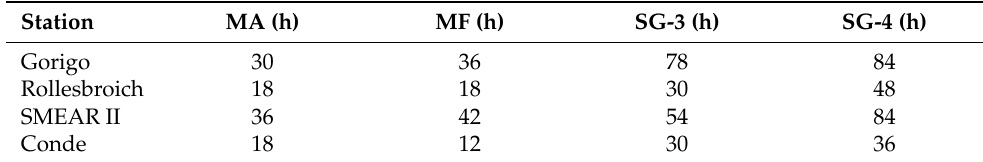
Table 3. Optimal window size (h) of various filters for the different